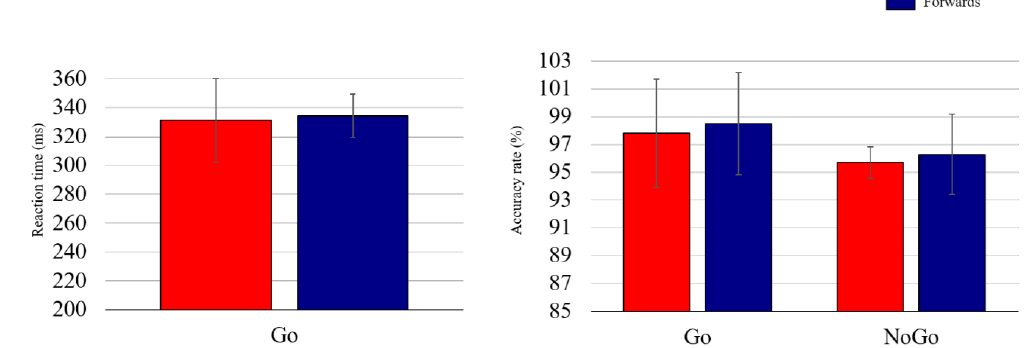
Figure 2. The behavioral performance of the guards and forwards groups.